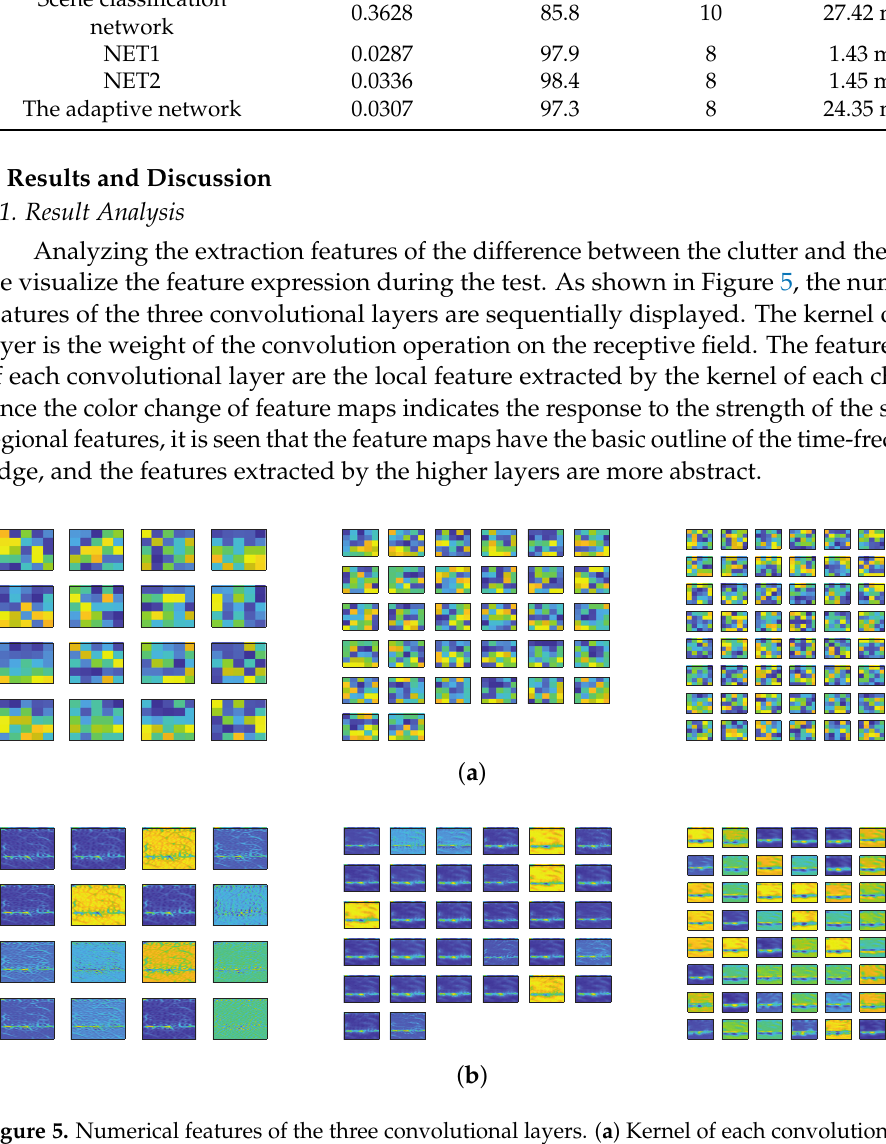
Figure 5. Numerical features of the three convolutional layers. ( a ) Kernel of each convolutional layer. ( b ) Feature maps of each convolutional